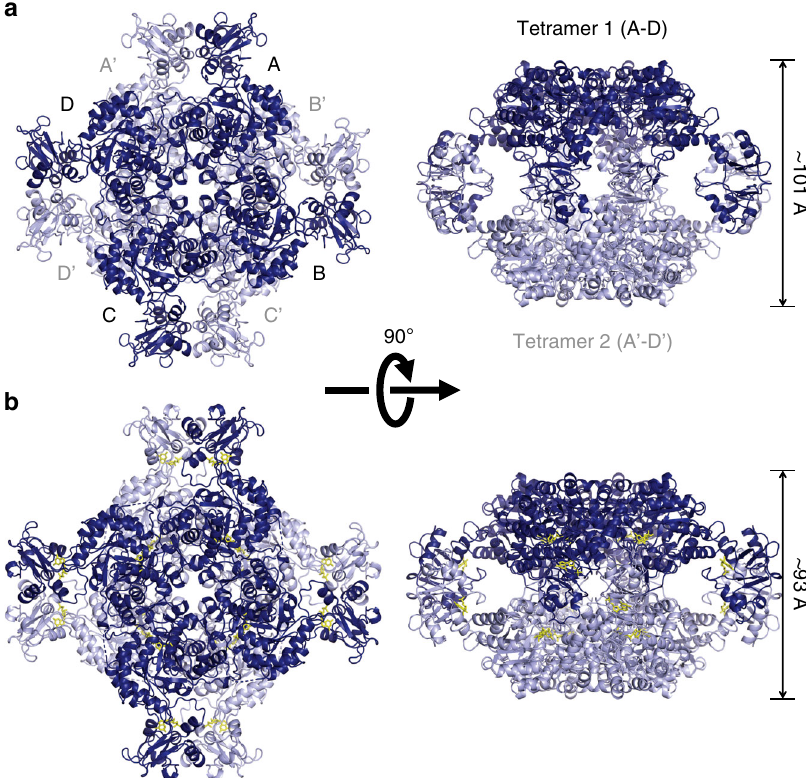
Fig. 3 Crystal structures of TbGMPR C318A with or without GMP. Cartoon representation of the octameric structures of C318A apo (relaxed form, a ) and C318A/GMP (twisted form, b ), each of which are composed of two tetramers. Tetramer 1 (subunits A – D) and tetramer 2 (subunits A ′ – D ′ ) are colored in light and dark blue, respectively. GMP molecules are shown as yellow stick representations. Note that C318A/GMP ( b ; right panel ) is compressed compared to C318A apo ( a ; right panel